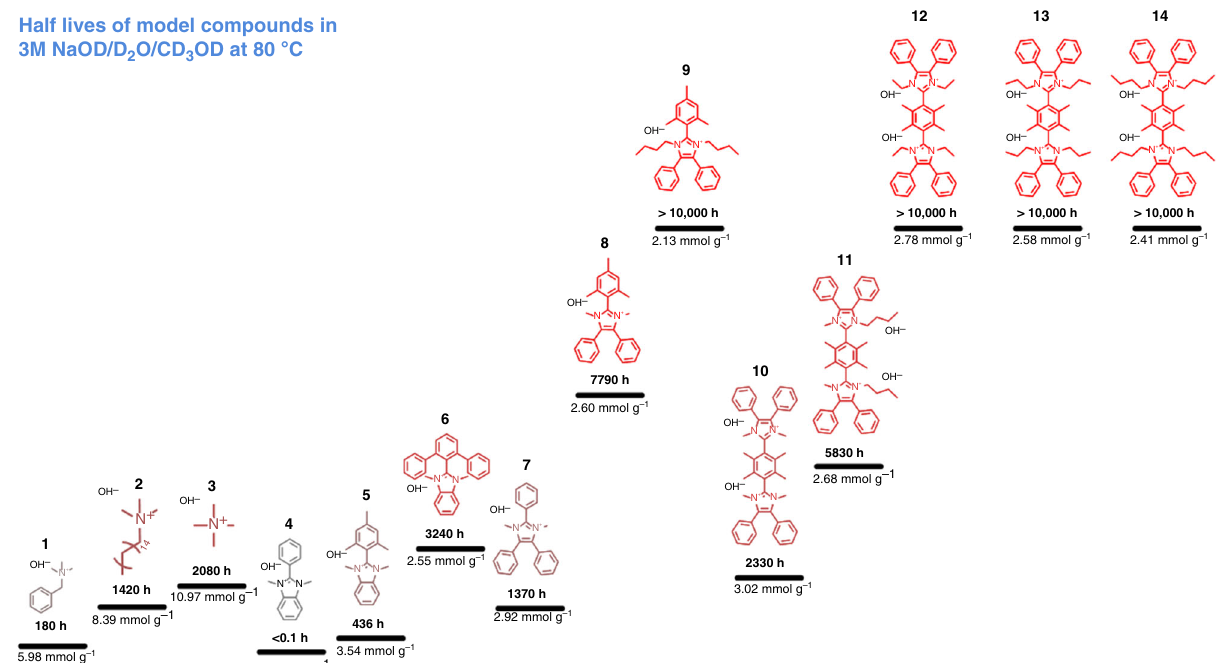
Fig. 1 Half-lives of cationic groups in 3 M NaOD/D 2 O/CD 3 OD. Half-lives of six novel imidazolium cations 9 – 14 prepared for this work, along with